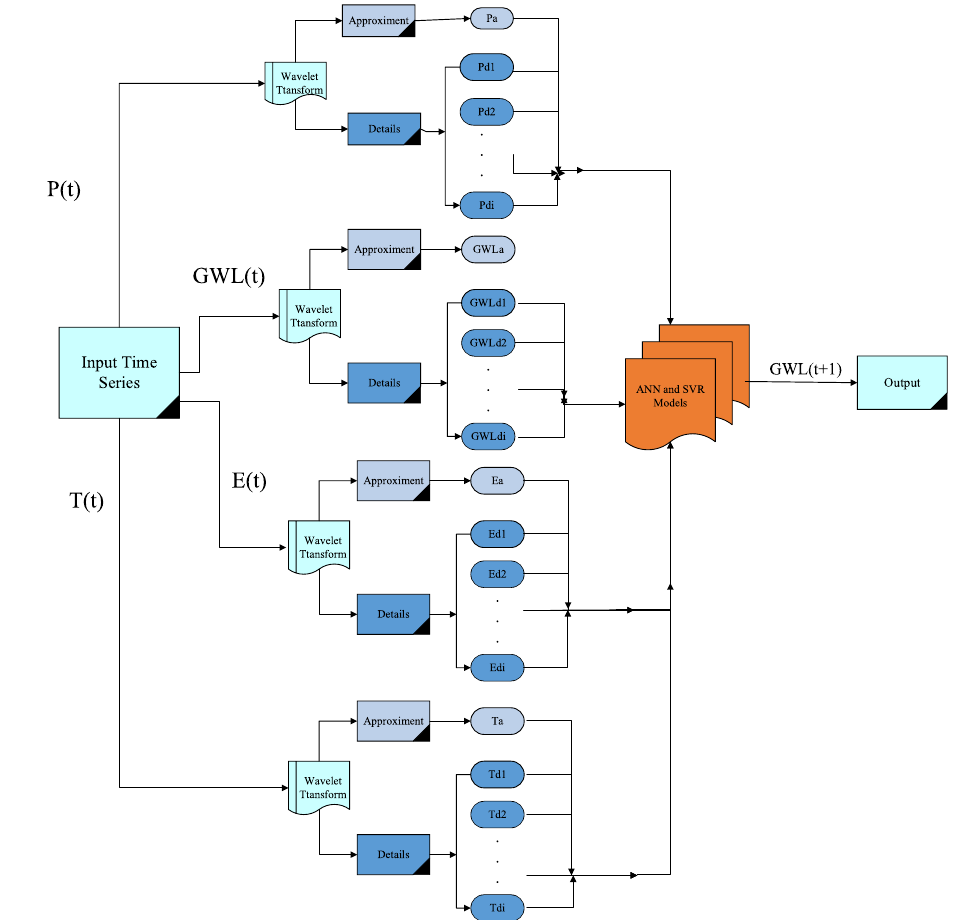
Fig. 5 Schematic diagram of the W-ANN and W-SVR